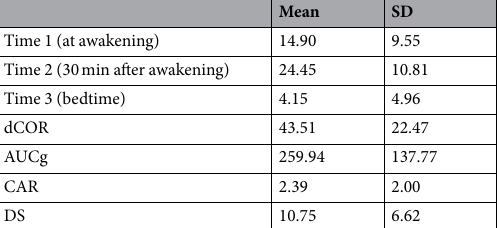
Table 1. Salivary cortisol data (nmol/L). Abbreviations: SD, standard deviation; dCOR, daily cortisol concentrations; AUCg, area under the curve with respect to ground (at 3 points); CAR, cortisol awakening response (i.e., area under the curve with respect to increase); DS, diurnal